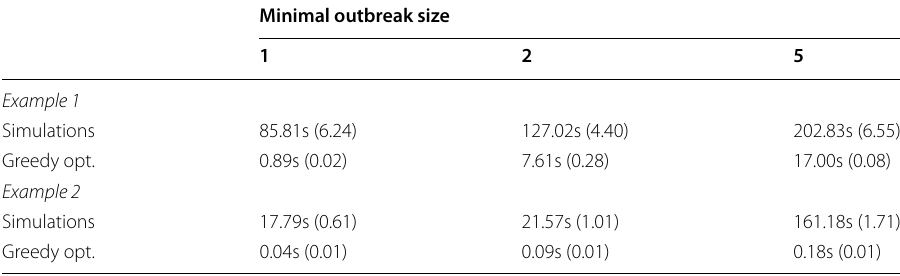
Table 1 Average run time (and standard deviation) in seconds of the simulation of the outbreak scenarios and the greedy optimization for all three objectives and different minimal outbreak